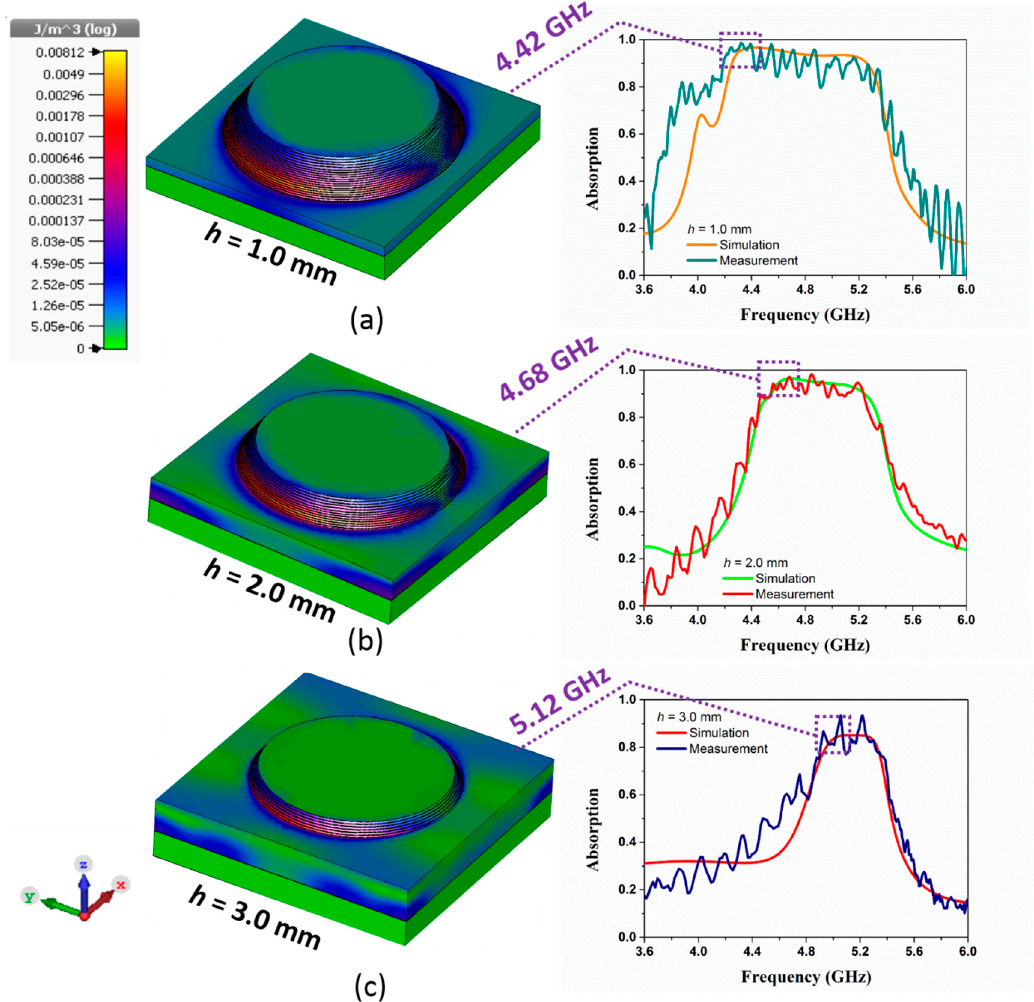
Figure 4. Distribution of the induced magnetic energy at the lowest absorption frequency and comparison between the simulated and measured absorption spectra at 303 K for ( a ) h = 1.0, ( b ) h = 2.0 and ( c ) h = 3.0 mm.